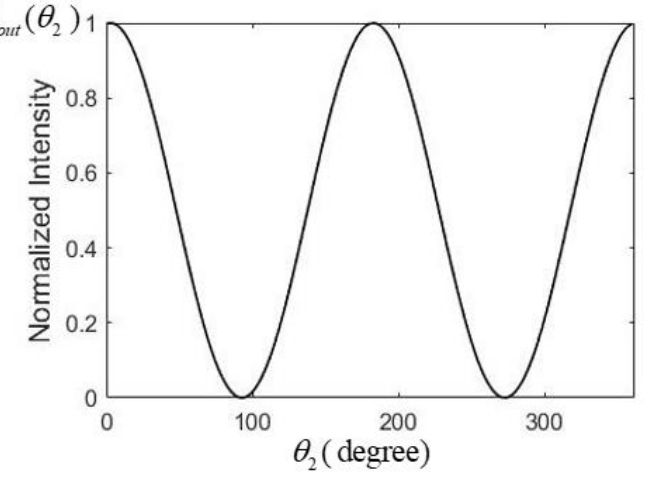
Figure 2. The normalized output intensity for d = 25 mm at λ = 1.0 µ